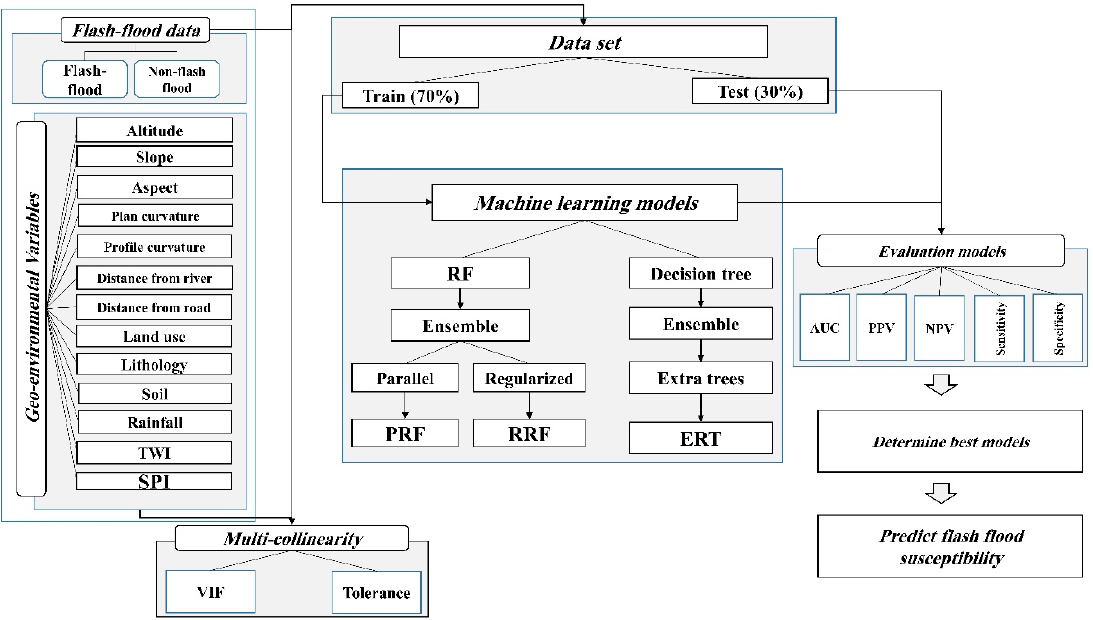
Figure 2. Methodological flow chart.